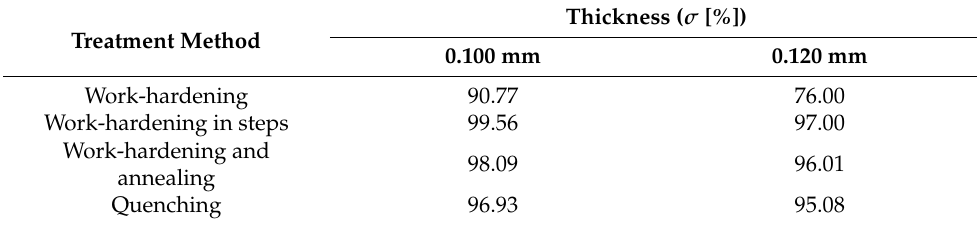
Table 5. Values of permeance reduction with different thickness